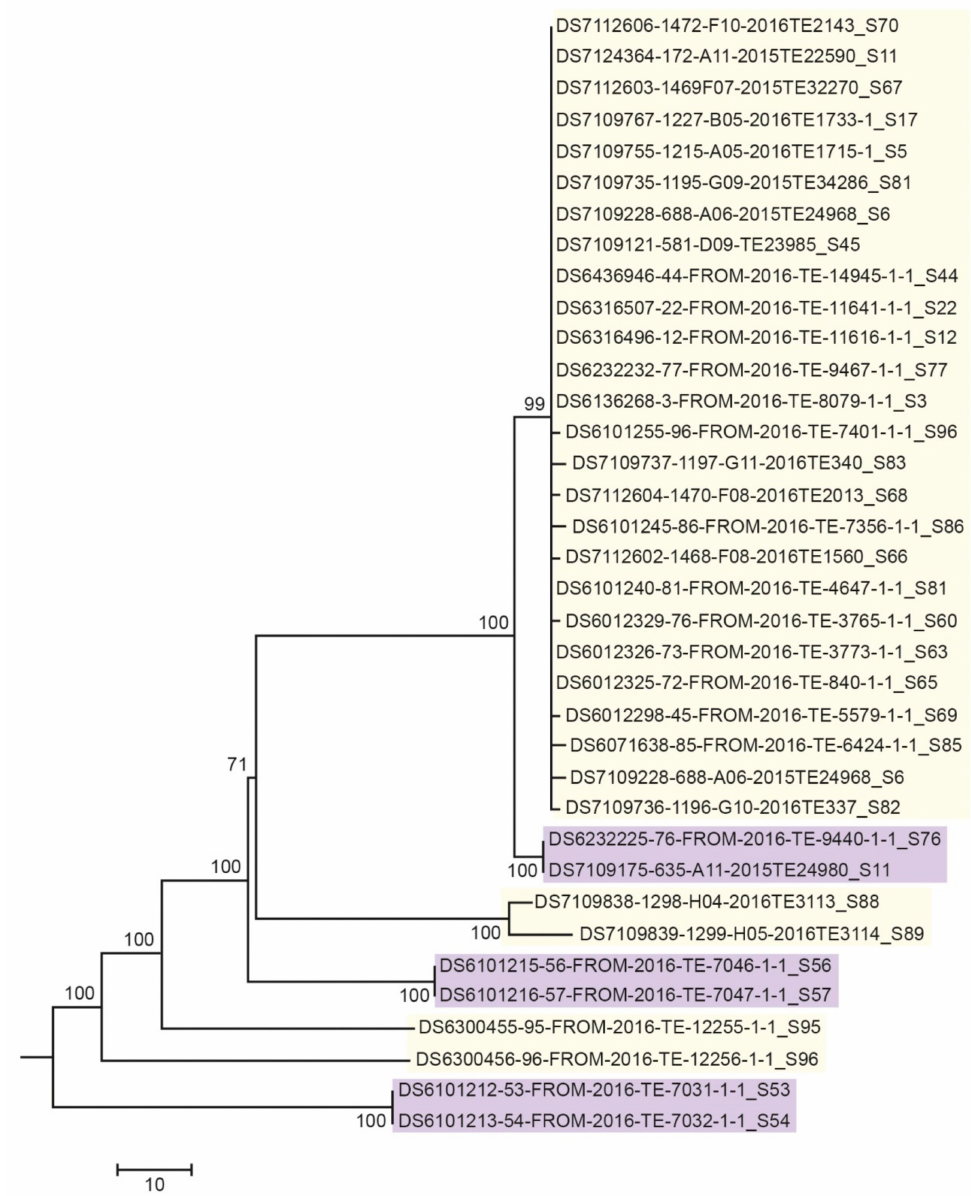
Figure 3. Phylogenetic relationships (neighbor joining (NJ)) among a selected subset of 38 strains analysed during the outbreak investigation. Strains showing pulsotype Apa I.0246 Asc I.0356 are highlighted in yellow; strains positive to real-time PCR but with a di ff erent pulsotype from the outbreak strain are highlighted in